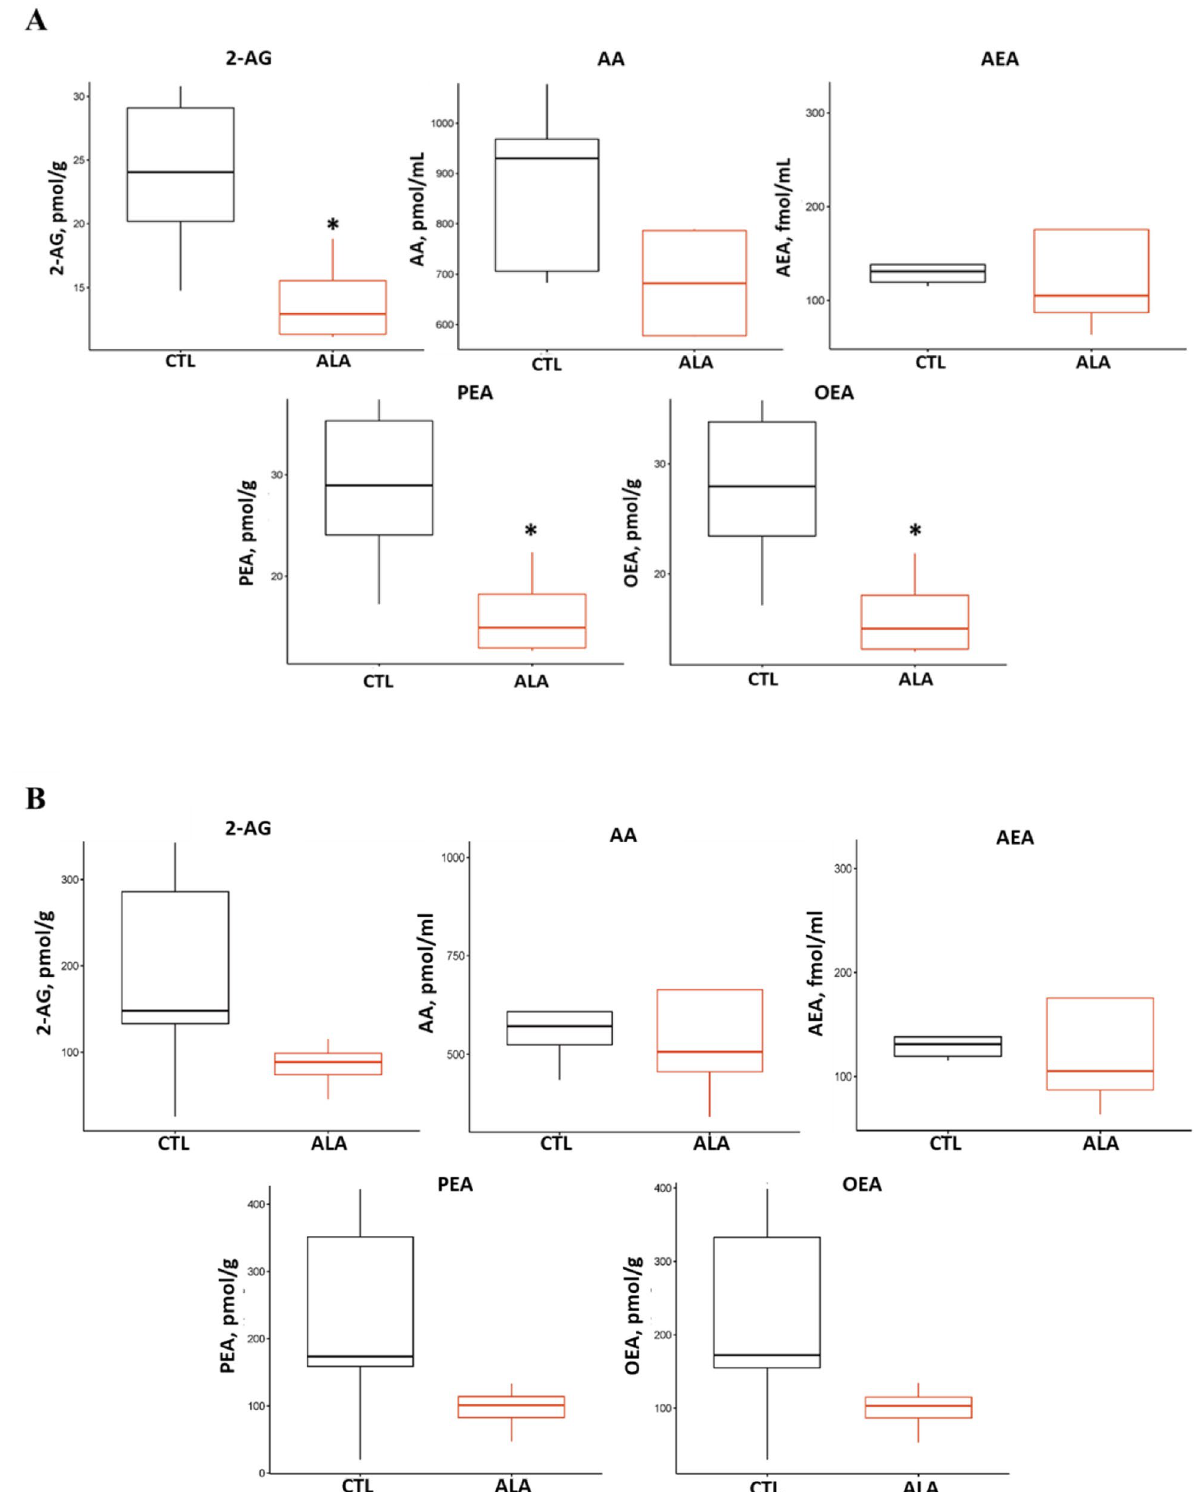
Figure 8. Endocannabinoid concentrations in plasma ( A ) and adipose tissue ( B ) at 20 min after glucose infusion from postpartum (PP) dairy cows supplemented with ALA. *P ≤ 0.05. Dairy cows were divided into two nutritional groups from 21 to 60 days PP; (i) CTL—encapsulated saturated fat, (ii) ALA—flaxseed supplement providing α-linolenic acid (ALA). n = 5 per treatment. 2-AG 2-arachidonoylglycerol, AA arachidonic acid, AEA anandamide, PEA N -palmitoylethanolamide, OEA N